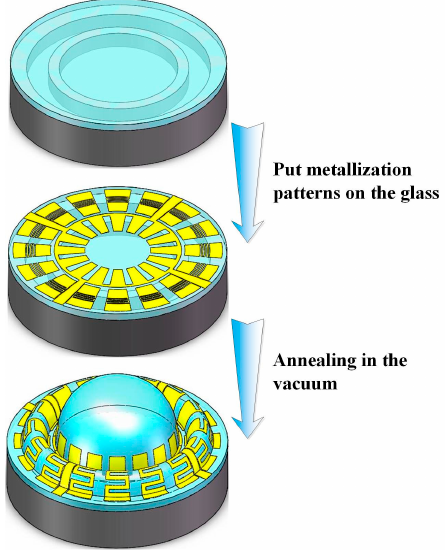
Figure 5. General fabrication of annular electrodes and the hemispheric shell.